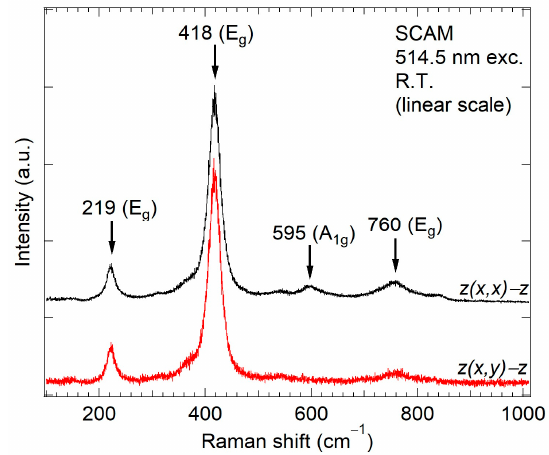
Figure 6. Raman spectra of SCAM by back-scattering from the c -plane with parallel (upper) and crossed (lower) polarization plotted in linear scale.